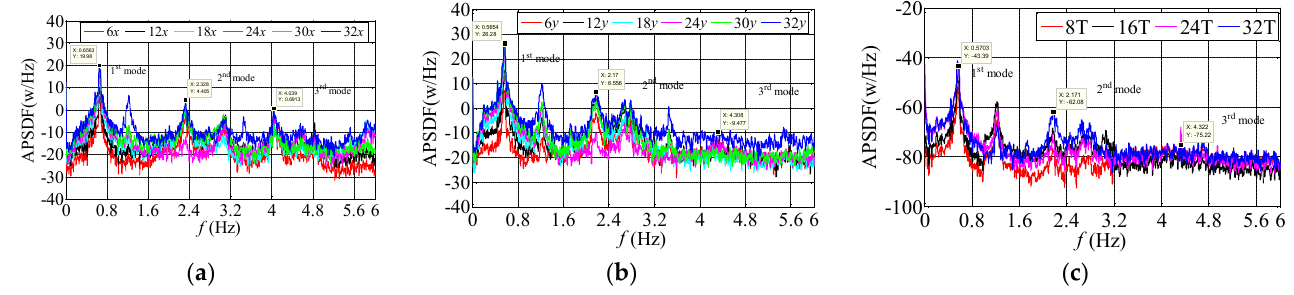
Figure 12. The measured APSDF when U 10min = 12.83m/s. ( a ) APSDF along x -axis; ( b ) APSDF along y -axis; ( c ) APSDF along torsional direction.